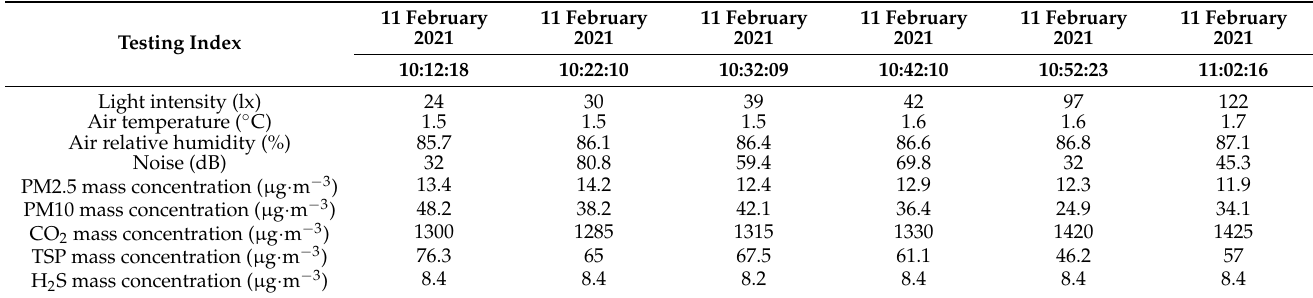
Table 2. Selected raw data of ambient air quality of sheep